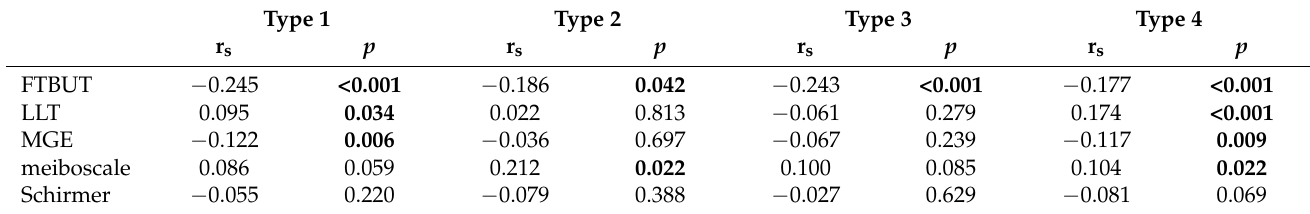
Table 5. Correlations between SPK and lipid/aqueous parameters.